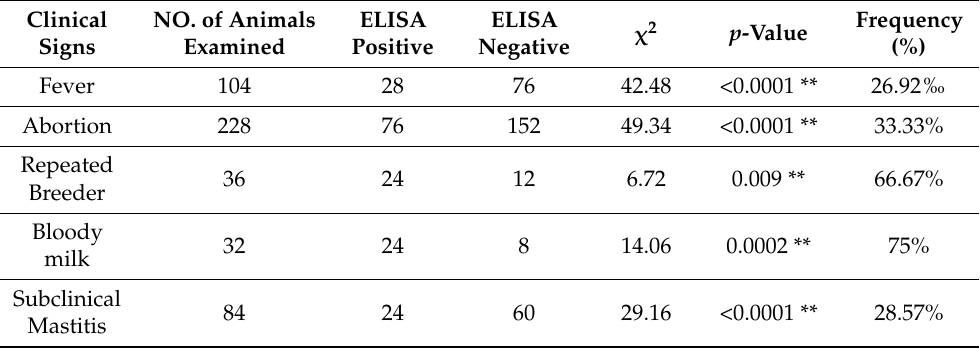
Table 5. Frequency of seroprevalence of leptospirosis among cattle according to clinical